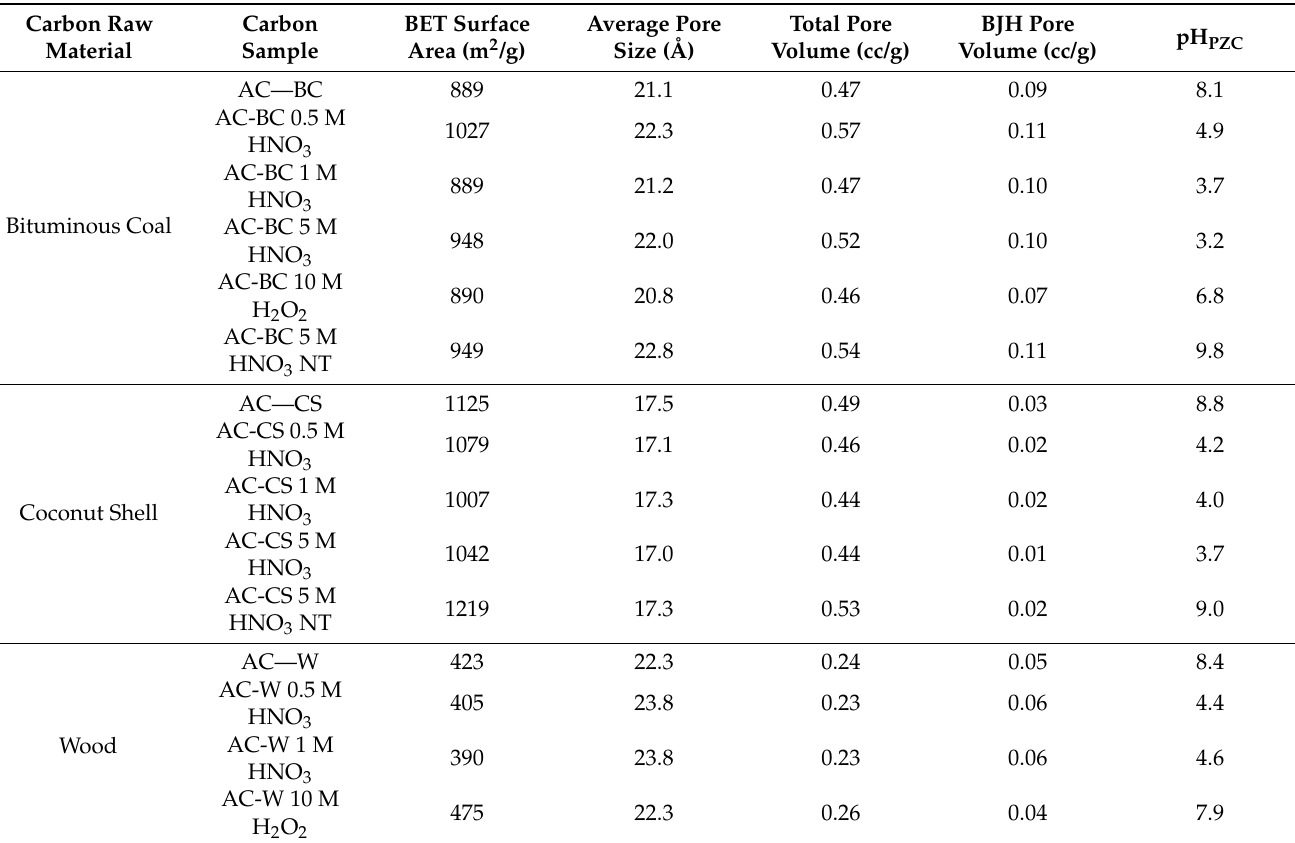
Table 3. Characterizations of treated and untreated activated